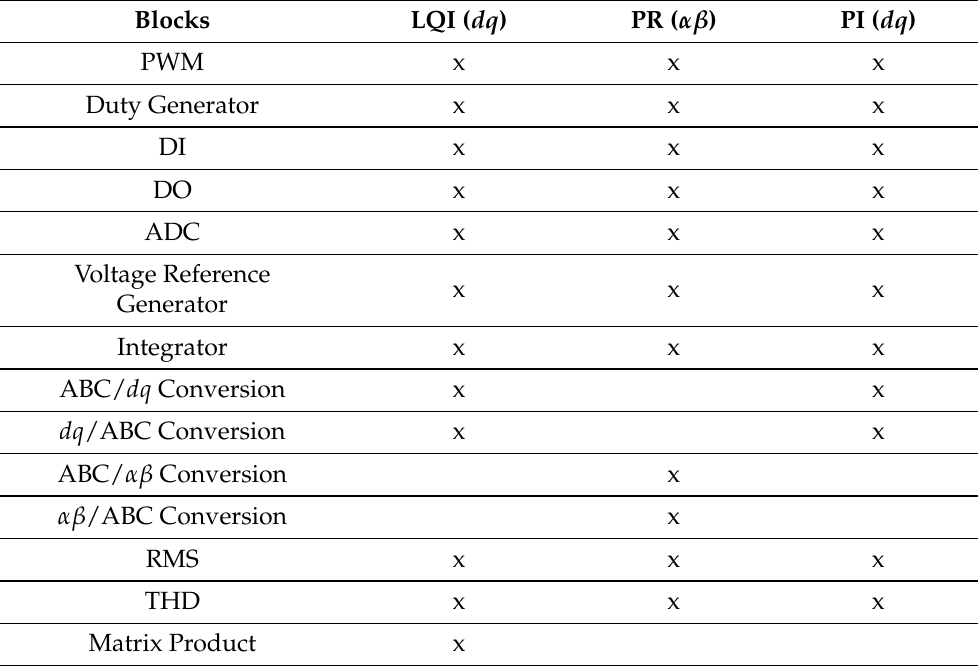
Table 2. Blocks and functions common in DC/AC